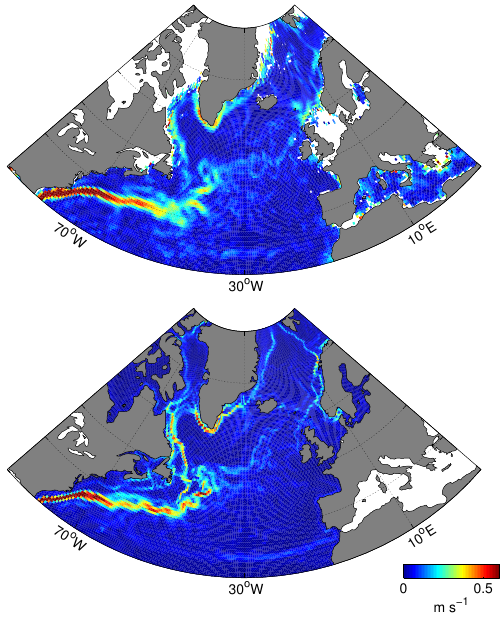
Figure 6. The mean model bias for temperature (left) and salinity (right), calculated as the model hindcast H05 estimate minus the observed value, averaged in 1 ◦ bins for the top 200m (top) and the 200–500m layer (bottom) for the period